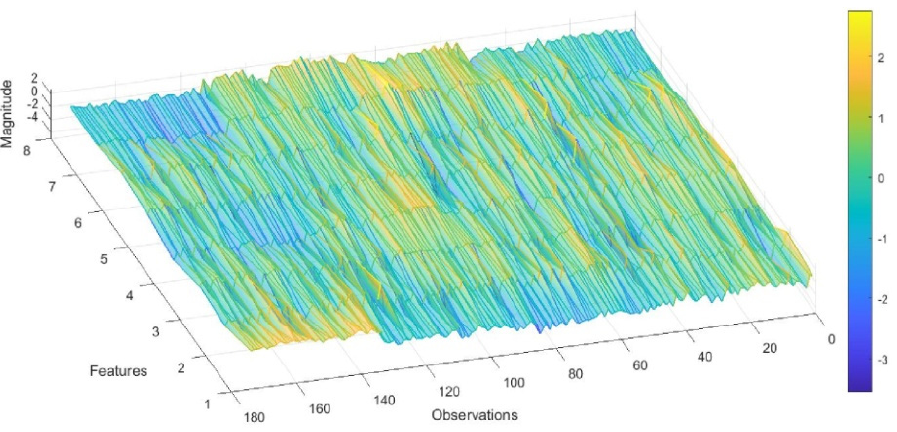
Figure 3. Three-dimensional representation of the parallel coordinates, showing the values of eight features for each observation obtained during the gas measurements.